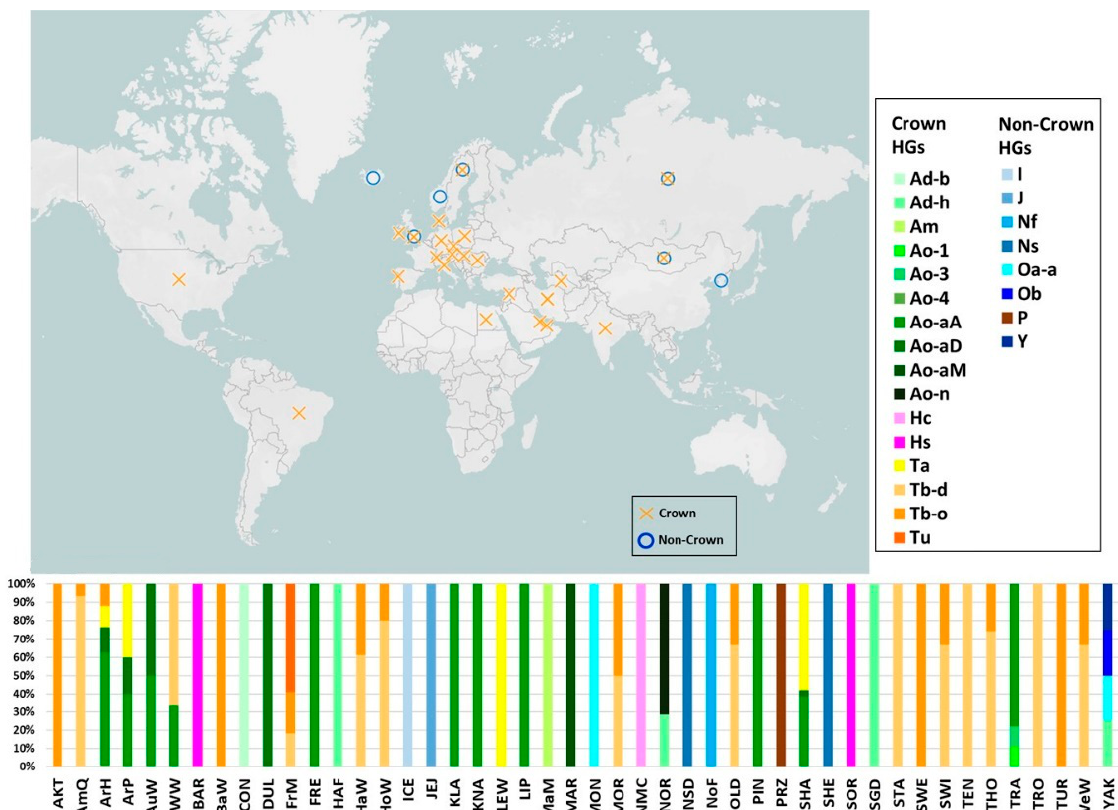
Figure 3. Worldwide distribution of crown and non‑crown haplogroups and frequencies of each Y chromosome HG among the 49 breeds analysed in [84,91,111,143]. Geographic origin, breed codes, frequencies and proportion of “crown” and ”non‑crown” groups for each breed are reported in Tables S4 and